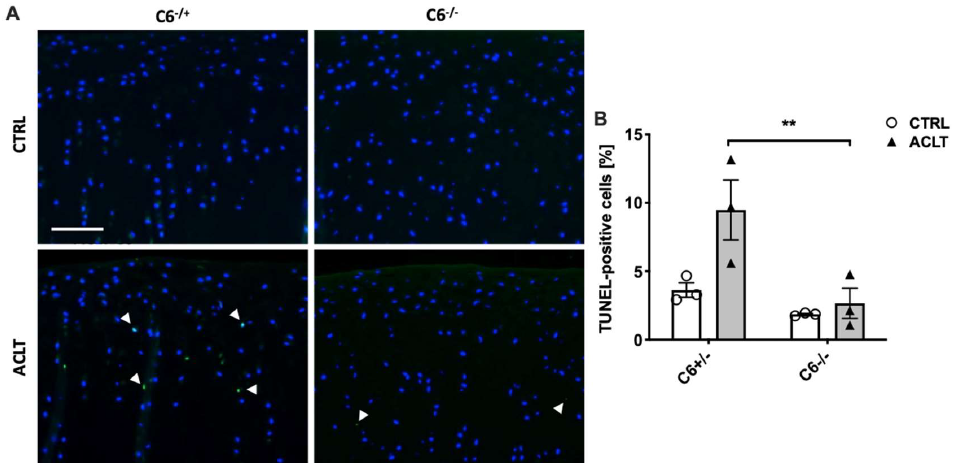
Figure 4. TUNEL staining of medial condyle sections. ( A ) Exemplary images of TUNEL-stained cartilage. Images were taken from the superficial and transitional zone. TUNEL-positive cells (green) are exemplarily indicated by white arrowheads; the white bar represents 100 µ m. ( B ) Corresponding statistical analysis of the apoptosis rate (percentage of TUNEL-positive chondrocytes). Data are charted as scattered bars with mean and SEM; white boxes = control joint, grey boxes = ACLT-operated joints. Statistically significant differences between groups ( n = 3 each) were depicted as: **: p ≤ 0.01.